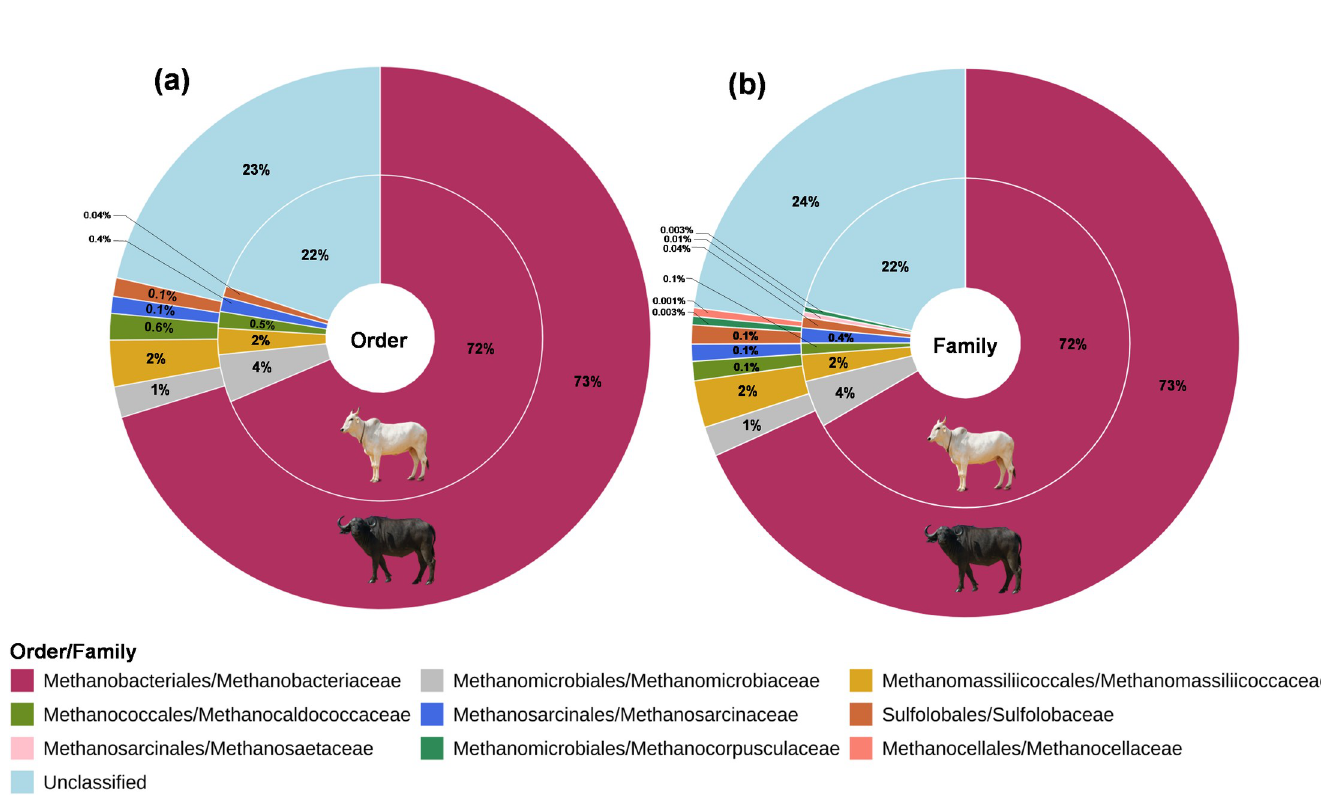
Fig 1. Ruminal archaea community composition in cattle and buffaloes at (a) the order level and (b) family level. The inner-circle represents the methanogens distribution in cattle; while the outer circle represents the distribution in buffaloes.